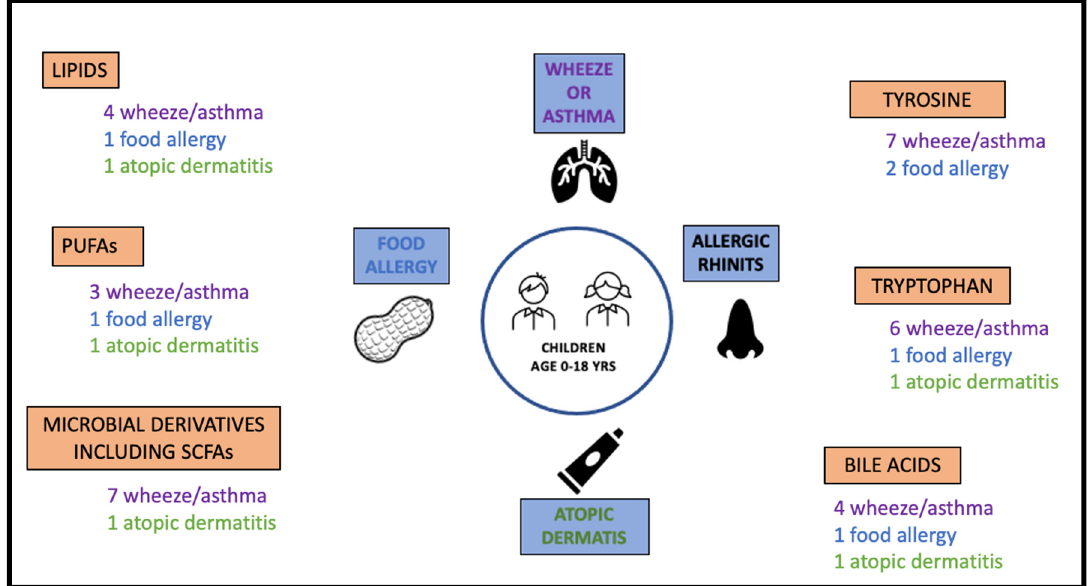
Figure 2. The number of studies showing significant associations between atopic diseases and metabolic pathways of interest.